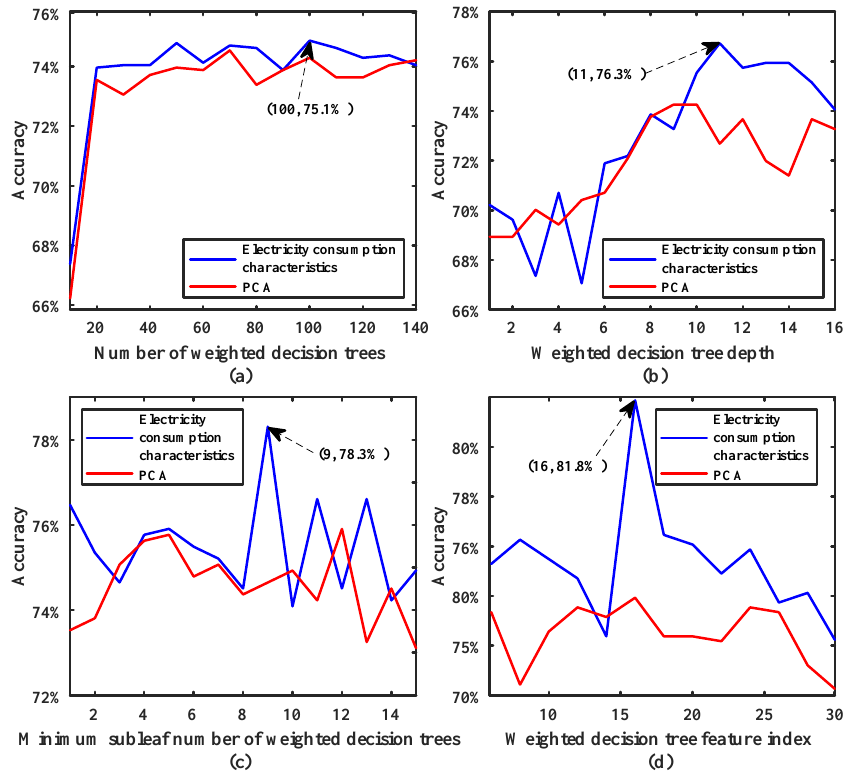
Figure 5. The performance of different features of the weighted random forest under different parameters.